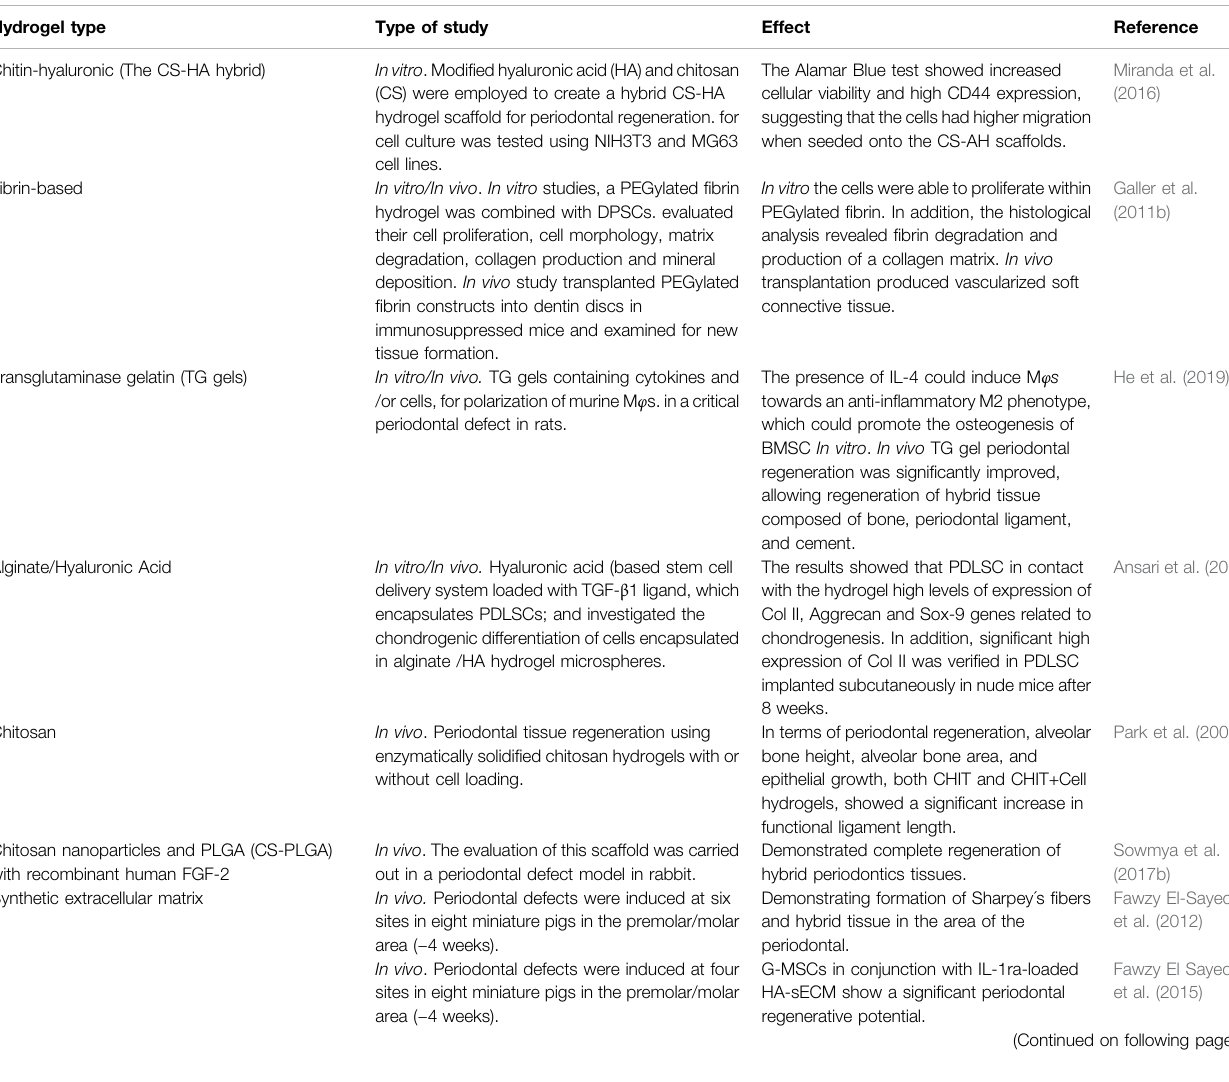
TABLE 2 | Hydrogel-based scaffolds for periodontal tissue